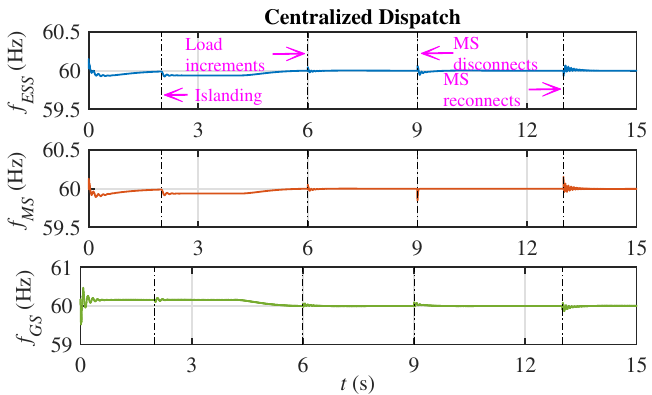
Figure 14. Frequencies of DGUs.